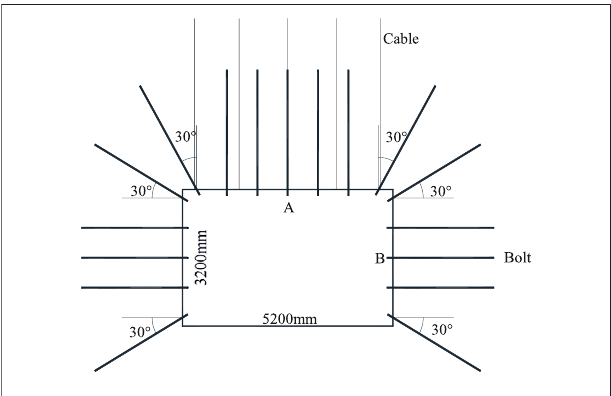
FIGURE 7 | Schematic diagram of the roadway support